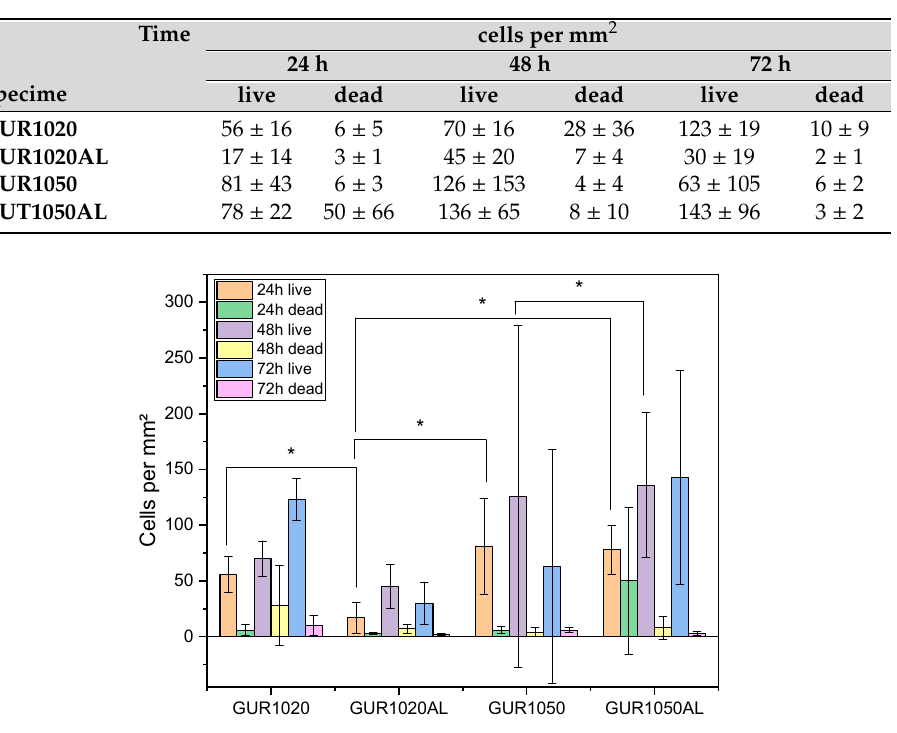
Figure 9. Overview of cells per mm 2 in conjunction with various materials, *significant di ff erence p < 0.05, N = 15. Figure 9. Overview of cells per mm² in conjunction with various materials, *significant difference p < 0.05, N = 15. Figure 9. Overview of cells per mm² in conjunction with various materials, *significant difference p < 0.05, N = 15.